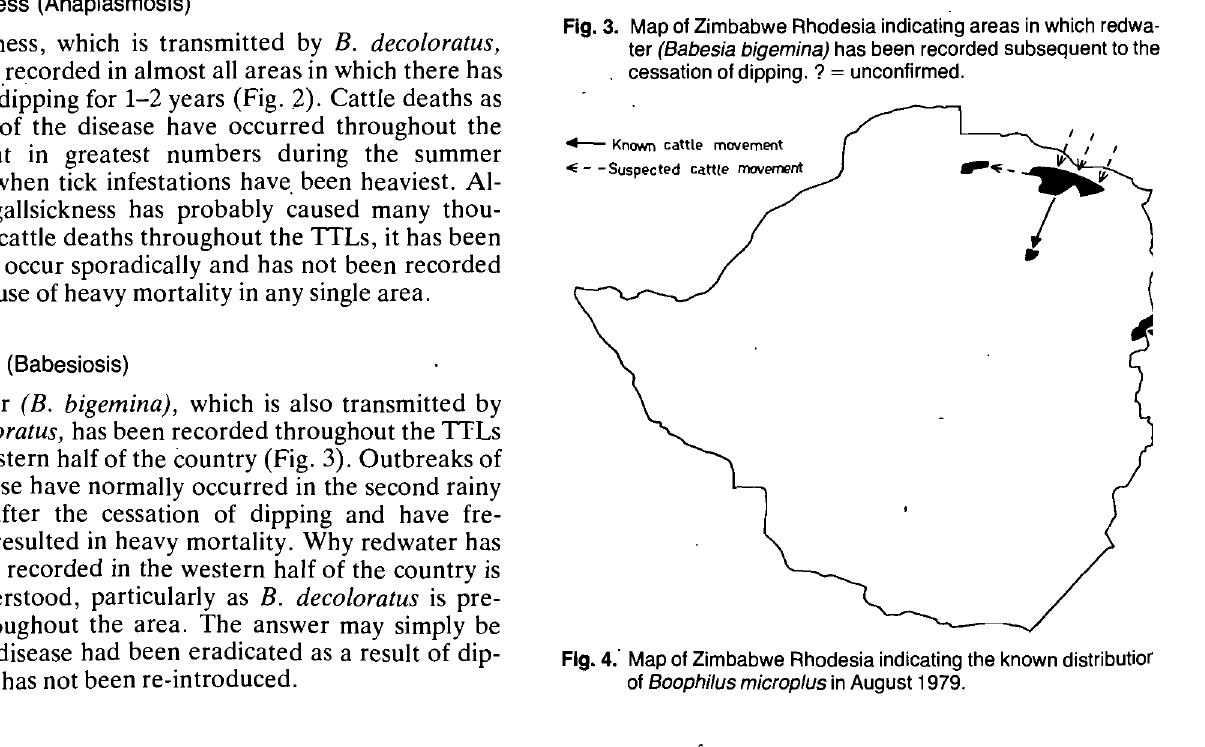
TYDSKRIF VAN DIE SUID-AFRIKAANSE VETERINERE